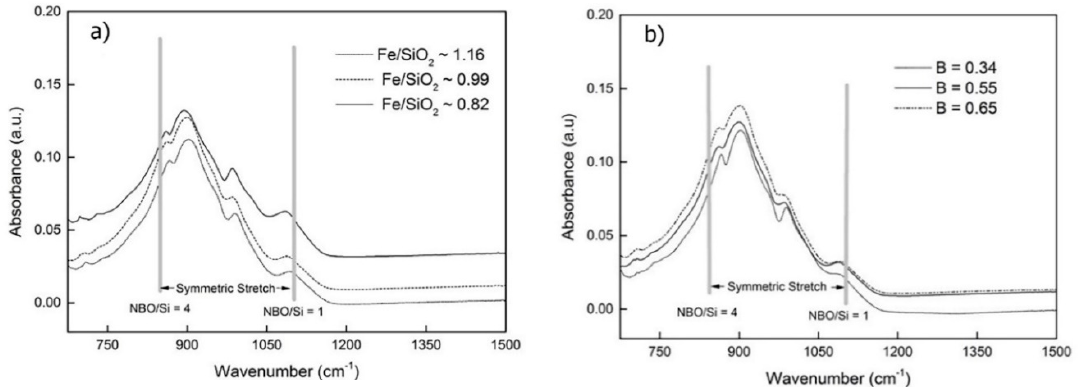
Figure 12. FTIR spectra of FCSM-Cu 2 O-PdO slags equilibrated with Cu ( p O 2 = 10 − 8 atm and T = 1300 Figure12. FTIRspectraofFCSM-Cu 2 O-PdOslagsequilibratedwithCu( p O 2 = 10 − 8 atmand T = 1300 ◦ C °C (1573 K)) at different: ( a ) Fe/SiO 2 ratios and ( b ) levels of basicity. (1573 K)) at di ff erent: ( a ) Fe / SiO 2 ratios and ( b ) levels of Table 6. FTIR peak shift and area fraction obtained from FTIR spectra of FCSM-Cu 2 O-PdO slags of different basicity and Fe/SiO 2 ratios.